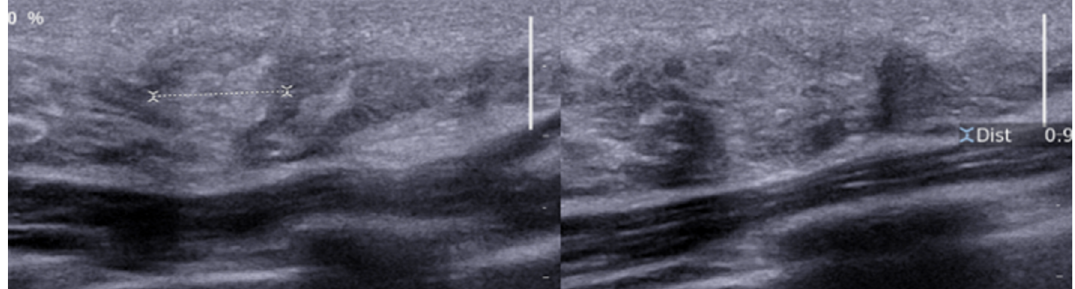
Fig. 12 Complex sclerosing lesions. Ultrasound in a young woman with a palpable mass, revealing a hyperechoic zone with irregular margins and acoustic shadow. Microbiopsy demonstrating benign complex sclerosing